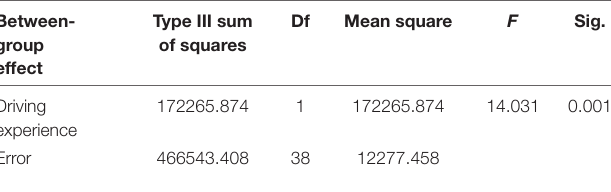
TABLE 8 | The test results of driving experience factor’s main